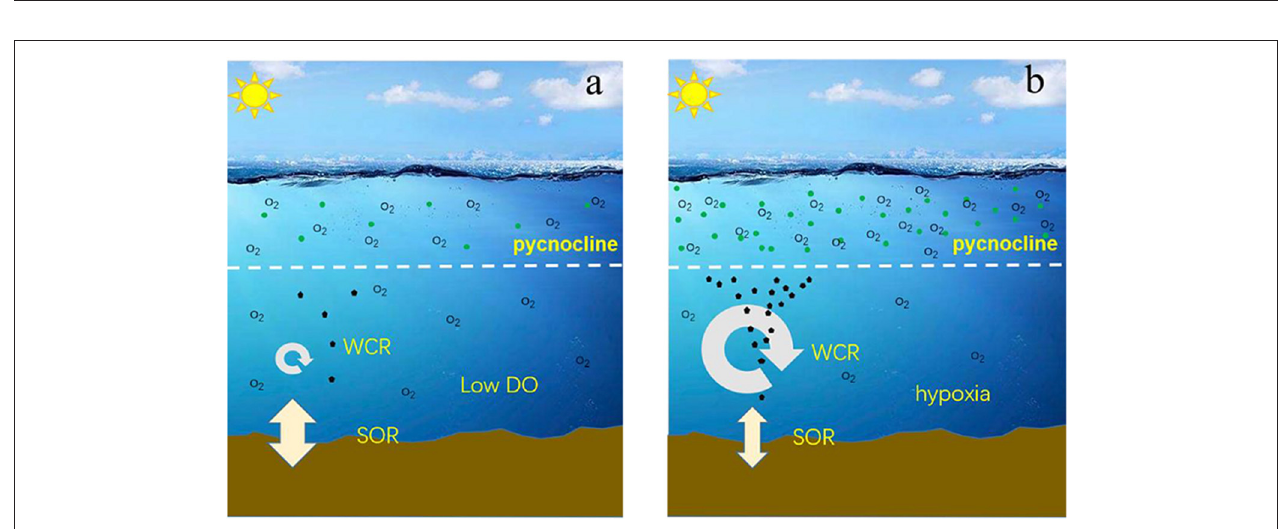
FIGURE 12 | The vertical distribution of the SOR% and WCR% contributions to total AOU at (A) station D3 and (B) station E2.